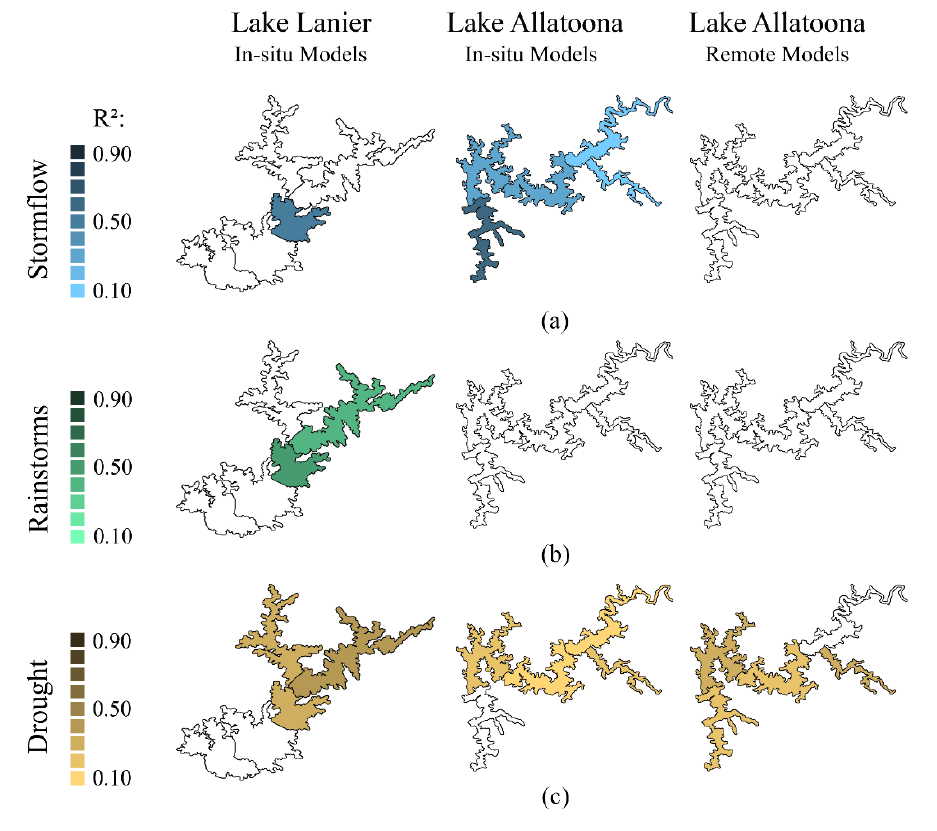
Figure 9. The variance-explained of each statistically significant linear model is shown by site. Note that r 2 is shown here without the direction of the slope. ( a ) Models showing relationships between flow in the tributaries and chlorophyll-a had the highest r 2 value in the Allatoona Creek reach at Lake Allatoona; ( b ) No significant relationships were found between chlorophyll-a and rainstorms in Lake Allatoona; ( c ) Drought indices, showed significant, often negative correlation with chlorophyll-a in most of the reaches in both reservoirs.